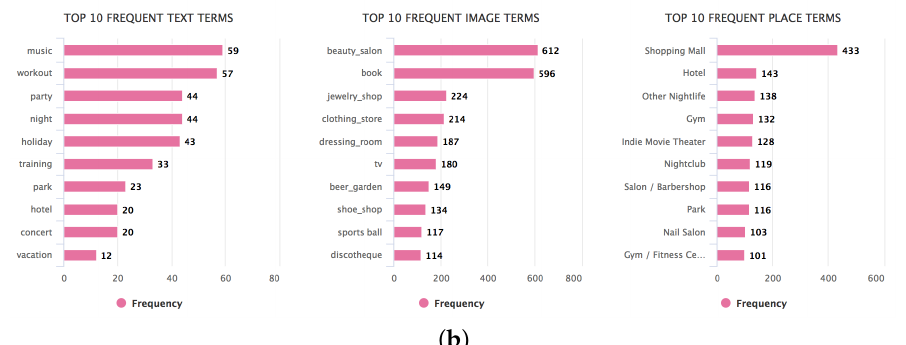
Figure 12. Bar charts visualizing the most occurring terms in social media posts classified to leisure activities in Amsterdam ( a ) and Istanbul ( b ). For readability purposes, in the figures we show only English terms.